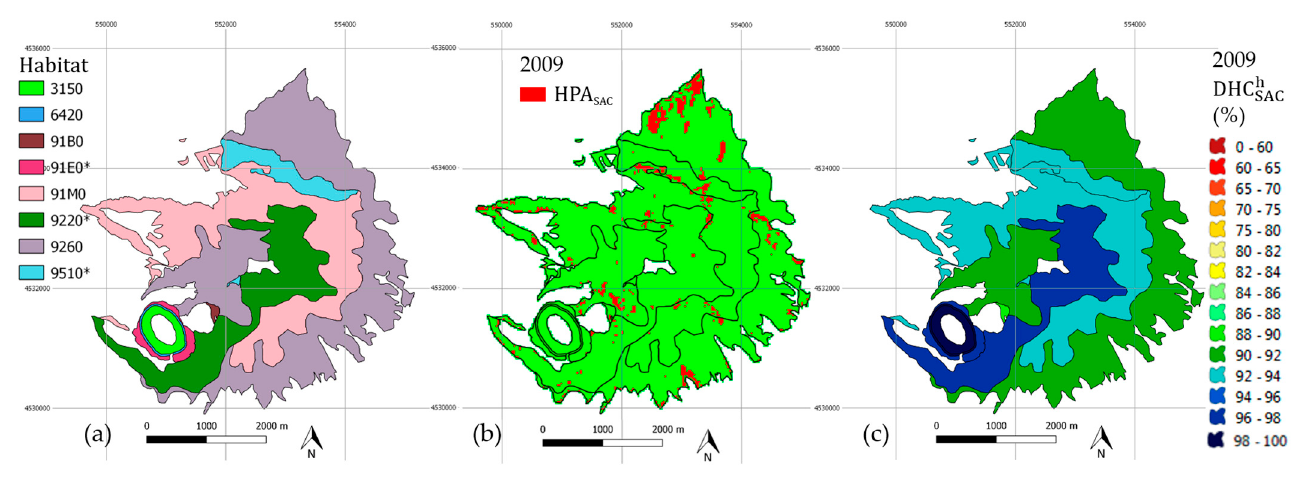
Figure 4. Monte Vulture SAC: ( a ) Map of habitats; ( b ) map of habitat priority areas; ( c ) map of the degree of habitat consistency (DHC) index. Maps ( b , c ) are obtained on the statistics of 2009 data at SAC level.